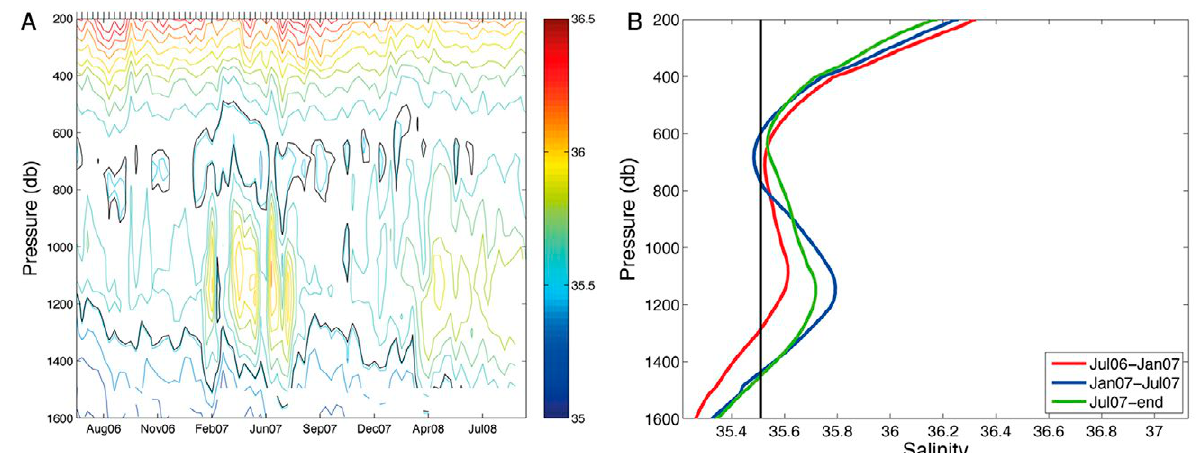
Fig. 6. – Salinities sampled by the float that tracked meddy F07. A, time-depth distribution. B, mean depth-salinity distributions grouped for three different periods as indicated; the vertical line corresponds to the salinity value of the deepest